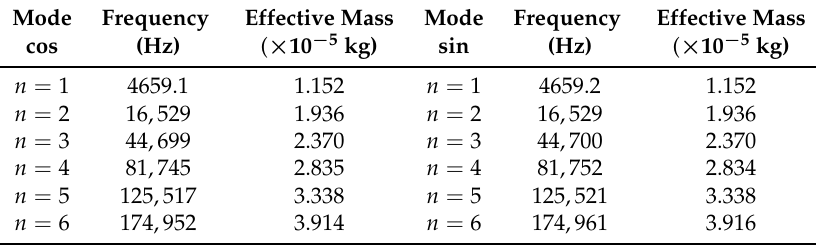
Table 4. Modal frequencies and corresponding effective masses of the